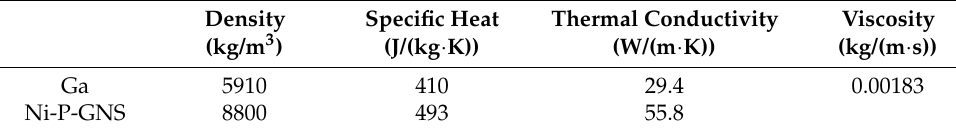
Figure 4. Simulation model sketch. Table 2. Parameters of the materials.